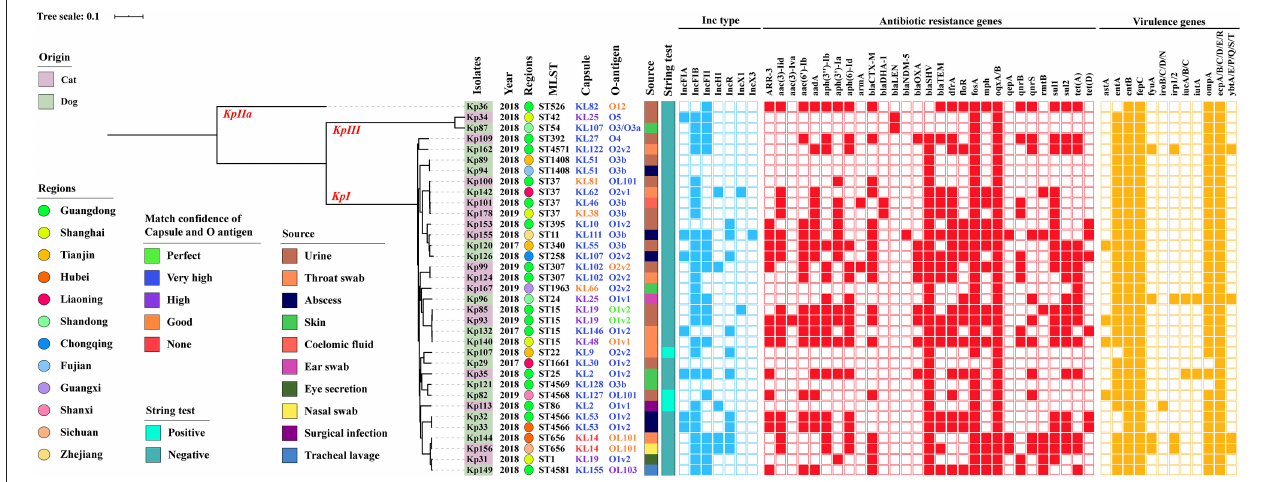
FIGURE 2 | Core genome-based phylogenetic tree and distribution of K. pneumoniae complex phylogroups, origins, isolated years, collected regions, MLST, capsular serotype, LPS O antigen, isolate sources, string test, Inc-type plasmids, antibiotic resistance genes, and virulence genes among isolates from companion animals. The origins, regions, KL/O match confidence, sources, and string test of K. pneumoniae complex are differentiated by color. Inc-type plasmids, antibiotic resistance genes, and virulence genes are denoted by filled squares for the presence and empty squares for absence.